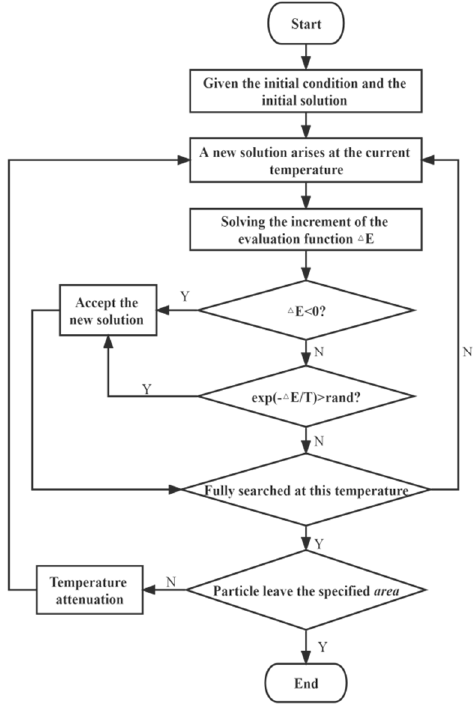
Figure 1. Flow chart of SA algorithm.